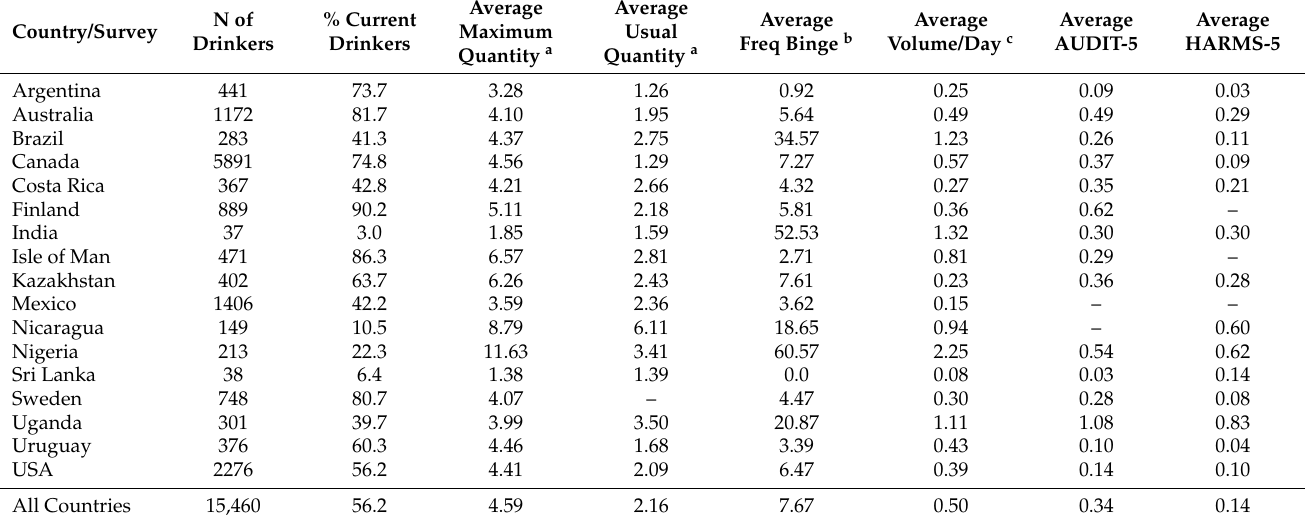
Table 3. Female Drinking and Problem Estimates.